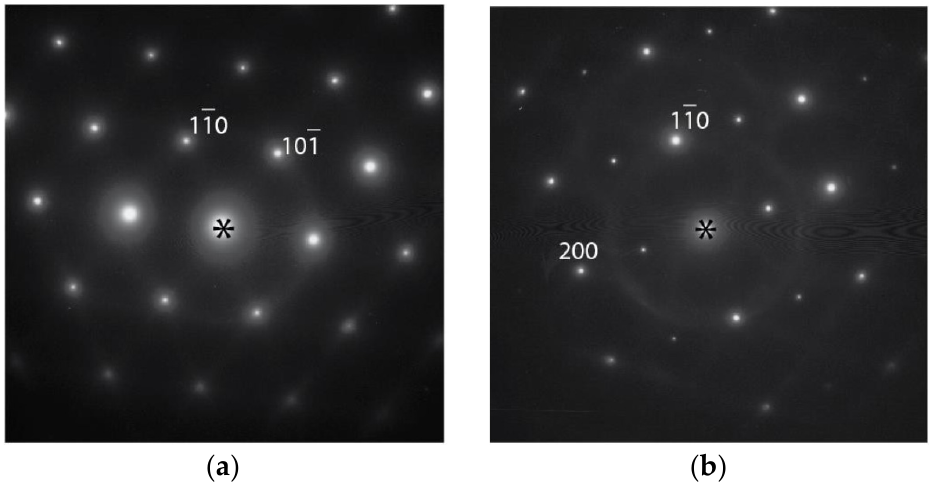
Figure 8. SAED taken from Phase III of Alloy P7 in two orientations: ( a ) with the [111] bcc zone axis; and ( b ) obtained by tilting around the (110)* to the [110] bcc zone axis. Table 3. EDS results (in at%) from selective spots in Figure 6a. B / A is the ratio between the sum of at% from other elements vs. Ti and Zr (bcc and C14) and Ti, Zr, and V